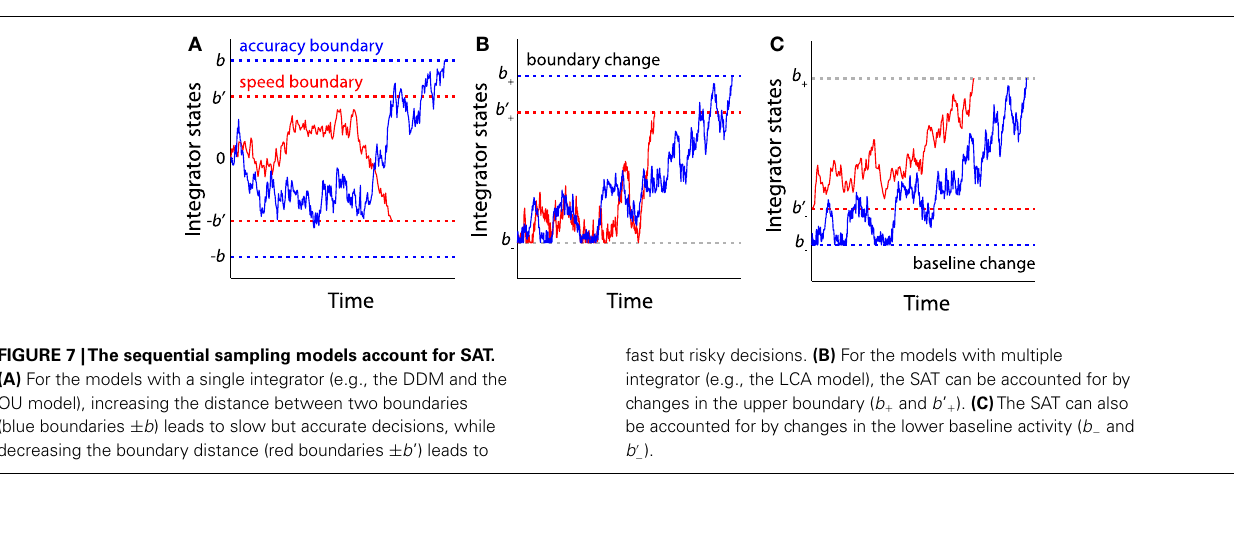
fast but risky decisions. (B) For the models with multiple integrator (e.g., the LCA model), the SAT can be accounted for by changes in the upper boundary ( b + and b ’ + ). (C) The SAT can also be accounted for by changes in the lower baseline activity ( b − and b (cid:48) −